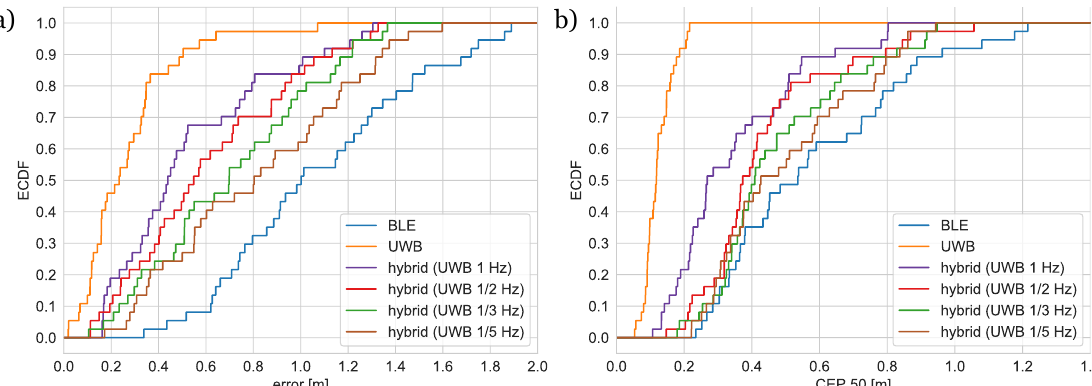
Figure 11. Empirical cumulative distribution functions of ( a ) localization error and ( b ) circular error probability (CEP) for 50% of the